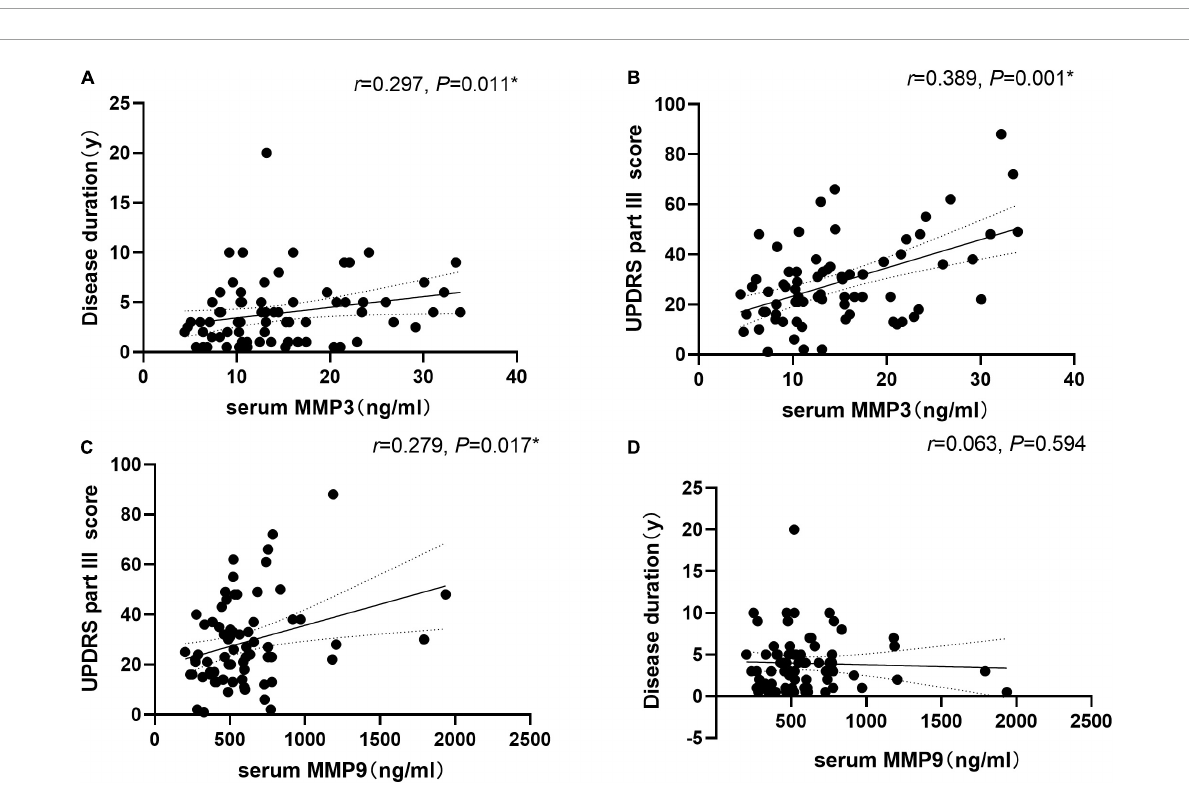
FIGURE3 Correlation of serum matrix metalloproteinase 3 (MMP3) and matrix metalloproteinase 9 (MMP9) levels with disease duration and disease severity in PD patients. (A) Serum MMP3 levels were positively correlated with disease duration (Spearman’s correlation coefficient r = 0.297, P = 0.011, and n = 73). (B) Serum MMP3 levels were positively correlated with UPDRS part III scores (Spearman’s correlation coefficient r = 0.389, P = 0.001, and n = 73). (C) Serum MMP9 levels were positively correlated with UPDRS part III scores (Spearman’s correlation coefficient r = 0.279, P = 0.017, and n = 73). * P < 0 . 05. (D) Serum MMP9 level was not correlated with the course of disease ( r = 0.063, P = 0.594, and n = 73).